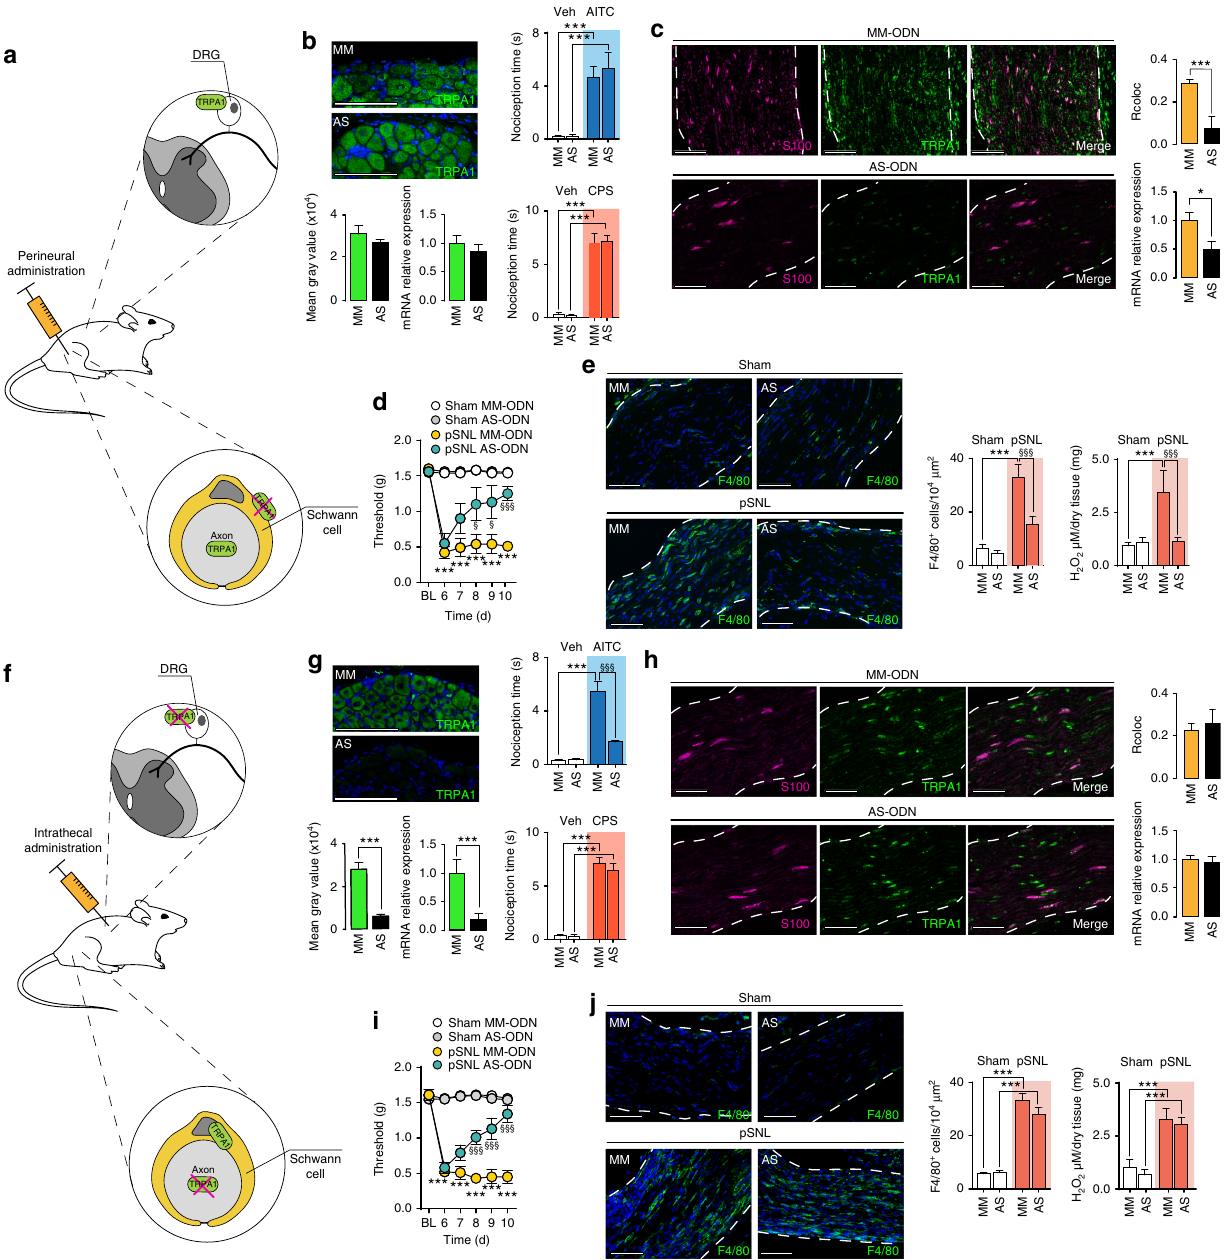
Fig. 6 Oxidative stress from Schwann cell TRPA1 recruits macrophages and signal pain in C57BL/6 mice. a , f Schematic representation of perineural/ intrathecal injection of TRPA1 antisense/mismatch oligonucleotides (AS/MM-ODN). b , g TRPA1 immuno fl uorescence (mean gray value) and TRPA1 mRNA relative expression in DRGs and acute nociception after perineural AITC (20 nmol 10 µ l − 1 ) or capsaicin (CPS, 1 nmol 10 µ l − 1 ) following perineural (10 nmol 10 µ l − 1 ) ( b ) or intrathecal (5 nmol 5 µ l − 1 ) ( g ) TRPA1 AS/MM-ODN treatment (once/day for 4 consecutive days) in C57BL/6 ( n = 6, *** P < 0.001 MM/AS AITC, CPS vs. MM/AS veh; §§§ P < 0.001 AS AITC vs. MM AITC; one-way ANOVA followed by Bonferroni post hoc analyses, Scale bars: 20 µ m). c , h Representative images (Scale bars: 50 μ m; dashed lines, perineurium), ( j ) colocalization value (Rcoloc) of S100/TRPA1 and mRNA-TRPA1 expression in sciatic nerve after perineural ( c ) and intrathecal ( h ) AS/MM-ODN ( n = 6, * P < 0.05; *** P < 0.001 AS vs MM; unpaired two-tailed Student ’ s t-test). d , i Mechanical allodynia, and ( e , j ) representative images, F4/80 + -cells, and H 2 O 2 -content (at day 10 after surgery) in sham/pSNL mice after perineural ( d , e ) and intratechal ( i , j ) AS/MM-ODN ( n = 8, *** P < 0.001 pSNL-MM-ODN vs. sham-MM-ODN; § P < 0.05 and §§§ P < 0.001 pSNL-AS-ODN vs. pSNL-MM- ODN; ( d , i ) two-way ANOVA followed by Bonferroni post hoc analyses and ( e , j ) one-way ANOVA followed by Bonferroni post hoc analyses) (Scale bars: 50 μ m; dashed lines, perineurium). Data are represented as mean ± s.e.m randomized to vehicle(s) or treatment(s) administration. The assessors (scientists temperature-controlled room (20 – 22°C) between 9 a.m. and 5 p.m. The sample who performed in vitro and in vivo tests), were blinded to the identity (genetic sizes chosen for animal groups were adequately powered to observe the effects background or allocation to treatment group) of the animals. Identity of the based on both our past experience in similar experimental settings and data animals was unmasked to assessors only after data collection. Every effort has been published by others. Some animals were excluded because of failure to reach the made to minimize the discomfort and pain of the animals in each phase of the training criteria or mortality. Exclusions for training were based on scores study. Animals were euthanized with inhaled CO 2 plus 10 – 50% O 2 . HC-030031 (2- established before starting experiments and routinely used. Animals were NATURE COMMUNICATIONS | 8: 1887 | DOI: 10.1038/s41467-017-01739-2 |